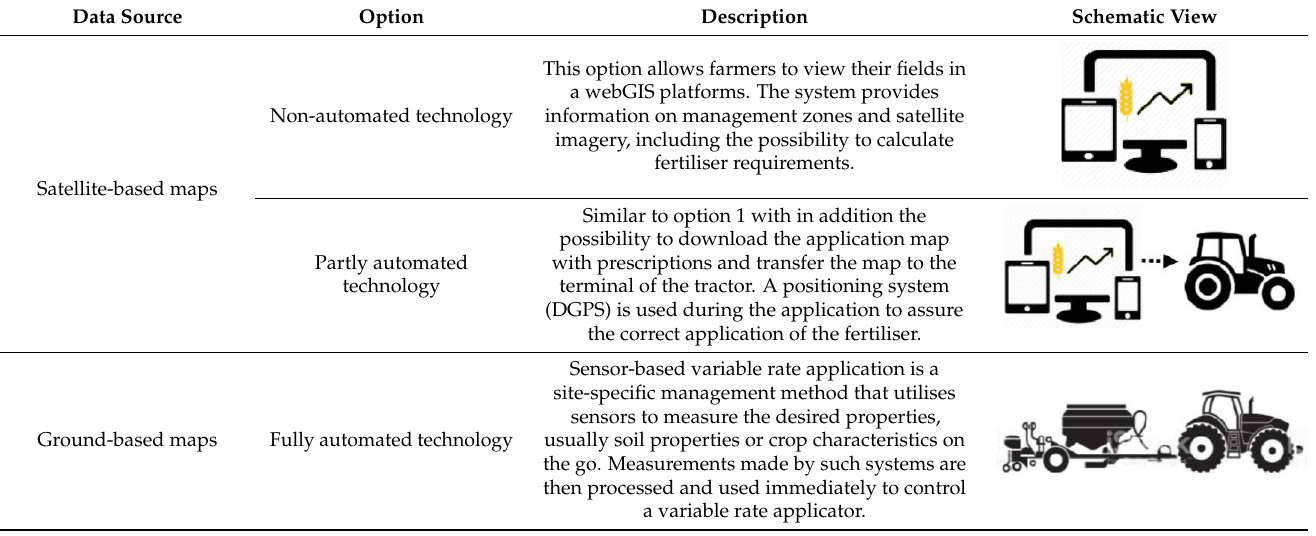
Table 1. Overview of technologies for variable rate application of fertiliser offered to the farmers in the choice experiment. Data Source